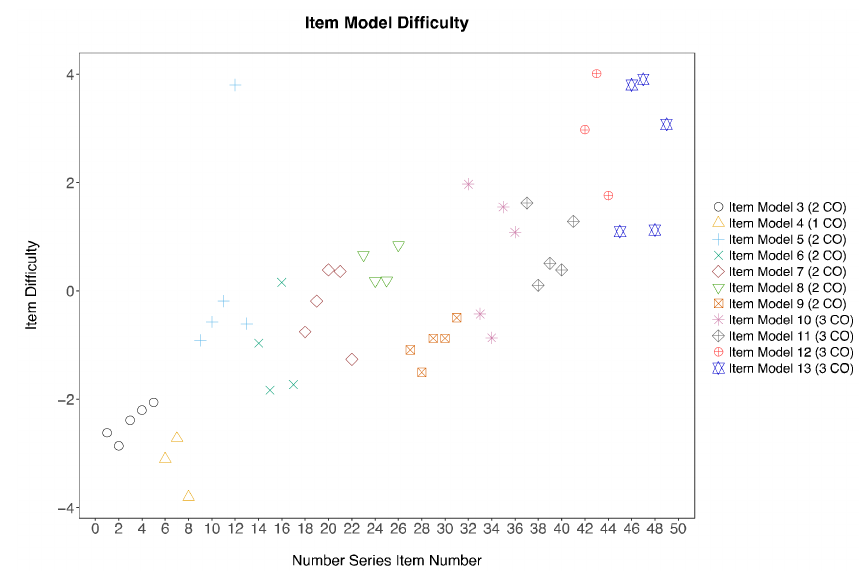
Figure 2. Item difficulty variations between and within item models using Rasch estimates. CO = cognitive